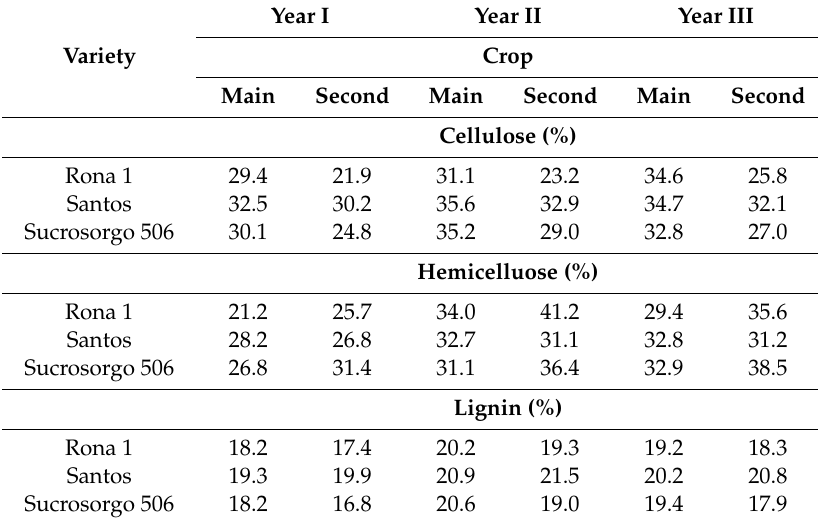
Table 3. Chemical composition of sorghum biomass for the main and second crop.